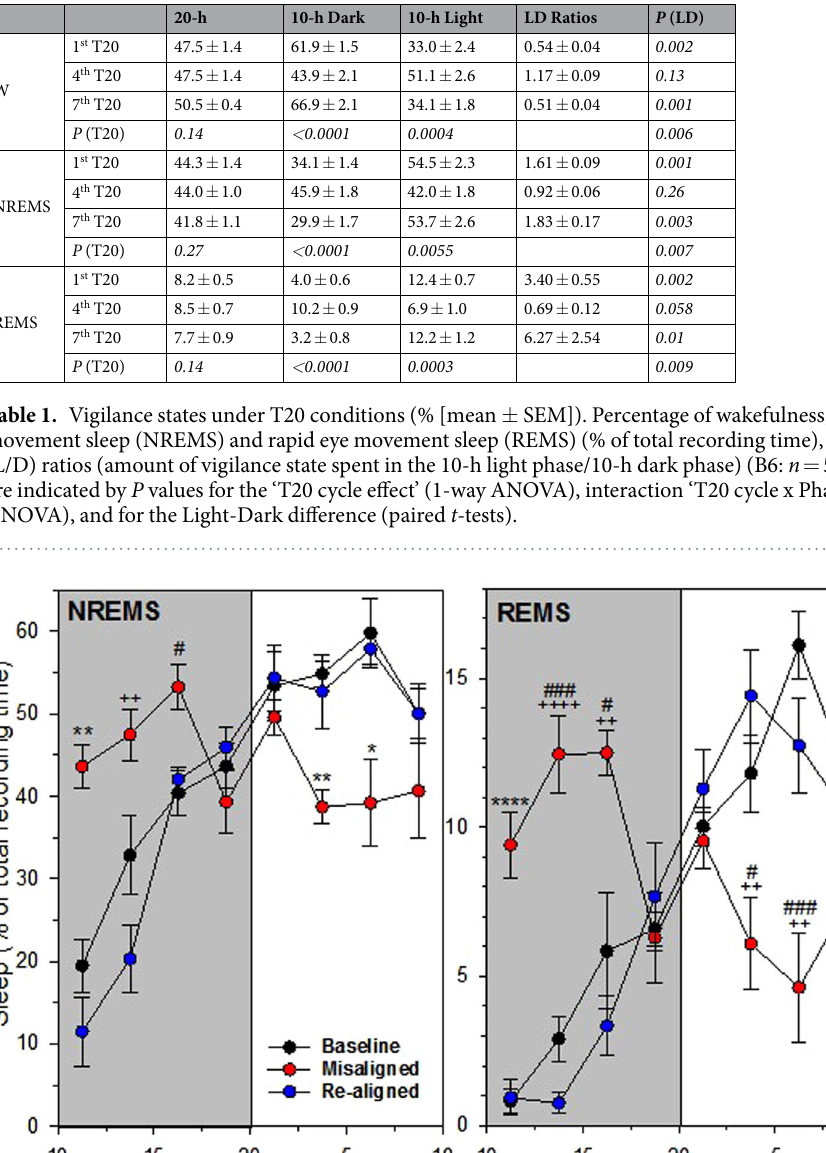
baseline and re-aligned cycles) and a relative reduction of waking episodes < 10 s during the light phase. The reduc- tion in very short waking episodes observed during the light phase reflects consolidated sleep and wakefulness (ANOVA, F 2,12 = 6.88, P = 0.01; Tukey adjusted post-hoc tests: P < 0.05). Whilst there was a trend for higher inci- dence of NREM sleep episodes with a duration of 20–30 s during the dark period, this was not statistically signifi- cant (ANOVA, F 2,12 = 2.90, P = 0.094; Tukey adjusted post-hoc test [misaligned vs. baseline/aligned cycle]: P = 0.08). Short REM sleep episodes of 10 s were also relatively increased during the light phase (ANOVA, F 2,12 = 7.13, P < 0.01; Tukey adjusted post-hoc tests [misaligned vs. re-aligned cycle]: P < 0.05). This could suggest an increased REM sleep pressure, resulting in a higher number of ‘attempts’ to enter REM sleep. Concurrently, there may be a competing drive to initiate NREM sleep, which prevents the expression of prolonged REM sleep episodes 34 . (2018) 8:15343 | DOI:10.1038/s41598-018-33480-1